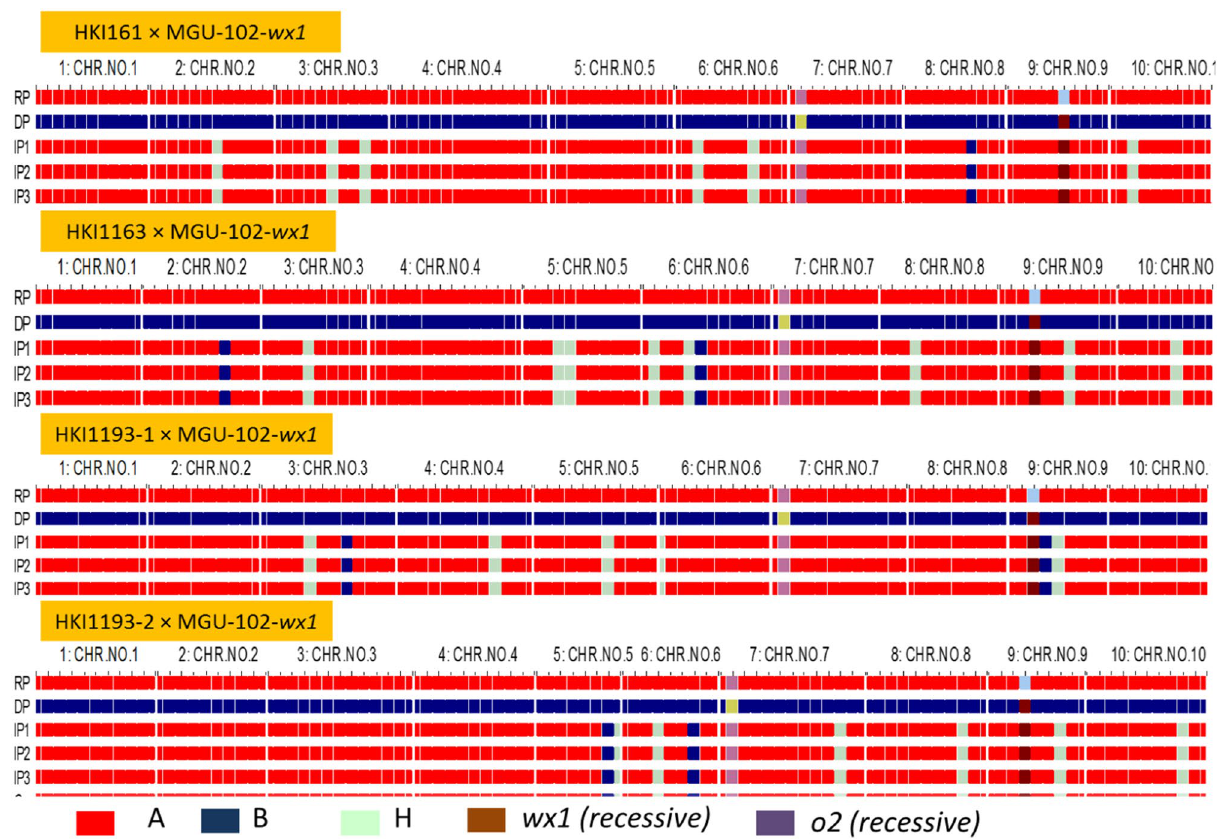
Figure 3. Graphical genotype of intogressed progenies across the three crosses. RP: recurrent parent; DP: donor parent; IP: introgressed progeny; CHR: